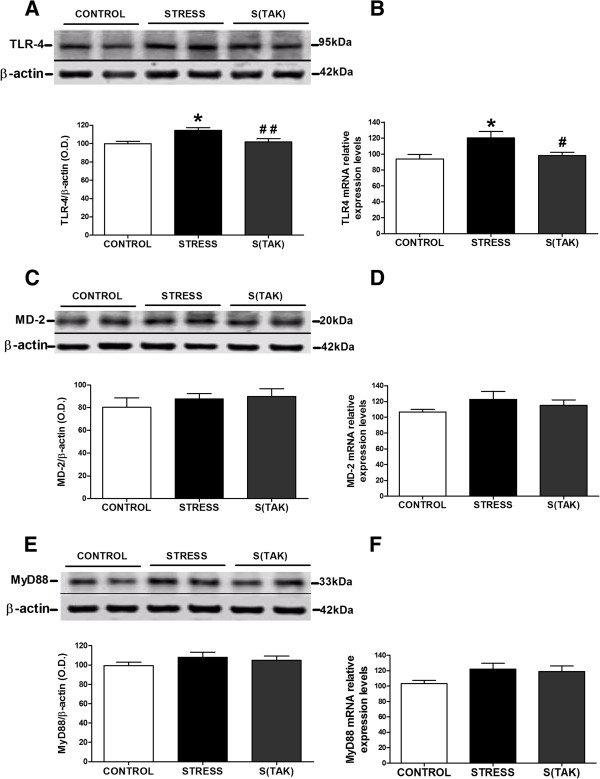
Toll-like receptor-4 upregulation is elicited by acute restraint stress exposure in rat brain frontal cortex. Protein levels of (A) toll-like receptor (TLR)-4, (C) myeloid differentiation protein-2 (MD2) and (E) myeloid differentiation factor 88 (MyD88) in brain frontal cortex samples of control (CONTROL) and stressed rats with (S(TAK)) or without (STRESS) TAK-242. The densitometric data of the respective band of interest are normalized by β-actin (lower band). Data are representative of two experiments (n = 3 per group in each experiment). O.D., optical density. mRNA relative levels of (B) TLR-4, (D) MD2 and (F) MyD88 in brain frontal cortex samples of control and stressed rats with or without TAK-242 (S(TAK) or STRESS, respectively). mRNA data are normalized by tubulin. Data represent the mean ± SEM (n = 4 to 5 per group). One-way analysis of variance followed by Newman–Keuls post hoc test. *P < 0.05 versus control; #P < 0.05 versus stress. ##P < 0.01 versus stress. This statistical data can be used for A and B.